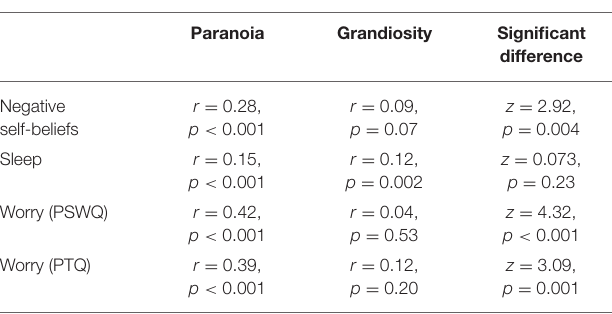
TABLE 3 | Summary of